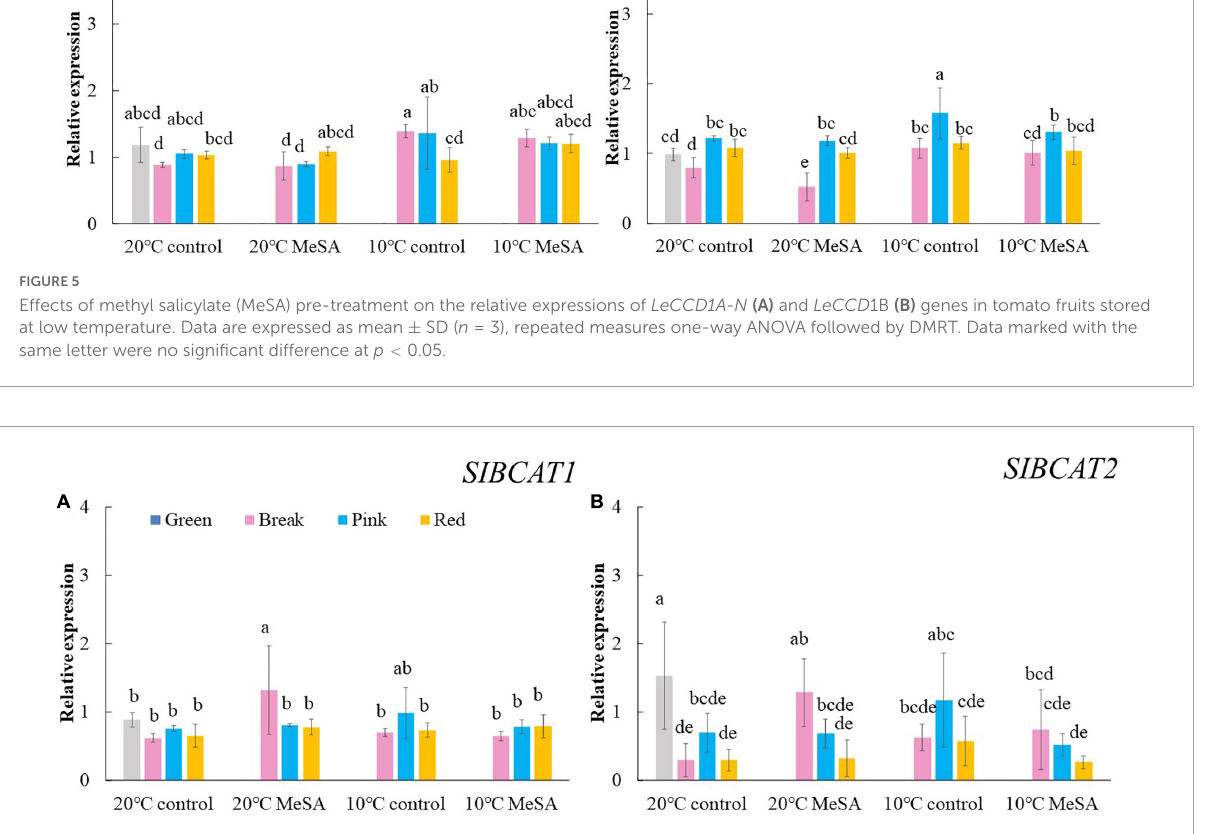
FIGURE6 Effects of methyl salicylate (MeSA) pre-treatment on the relative expressions of slBCAT1 (A) and slBCAT2 (B) genes in tomato fruits stored at low temperature. Data are expressed as mean ± SD ( n = 3), repeated measures one-way ANOVA followed by DMRT. Data marked with the same letter were no significant difference at p <